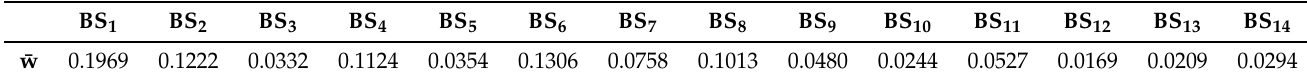
Table 11. The importance weight of business scenarios in TrainTicket.